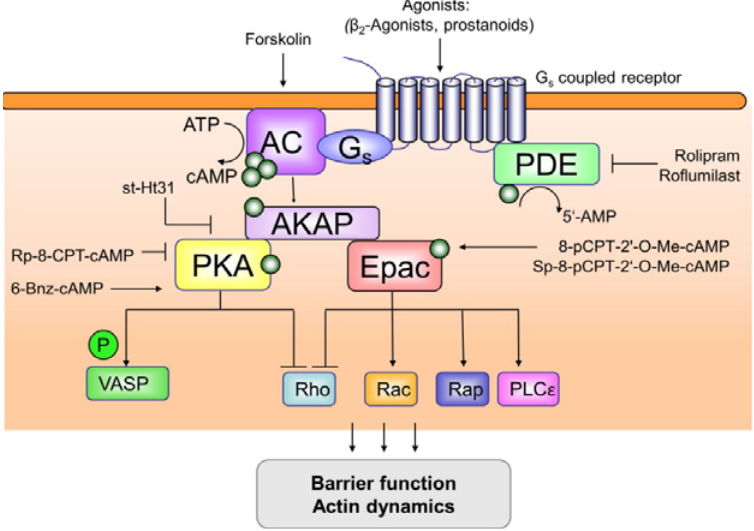
-protein coupled s -agonists and 2